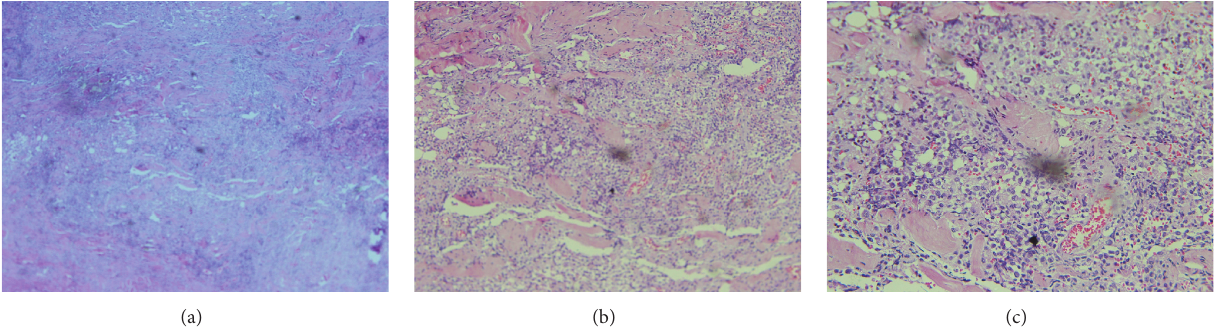
Figure 3: Histological view of the laryngeal lesion (magnification: (a) × 10, (b) × 100, and (c) × 1000).